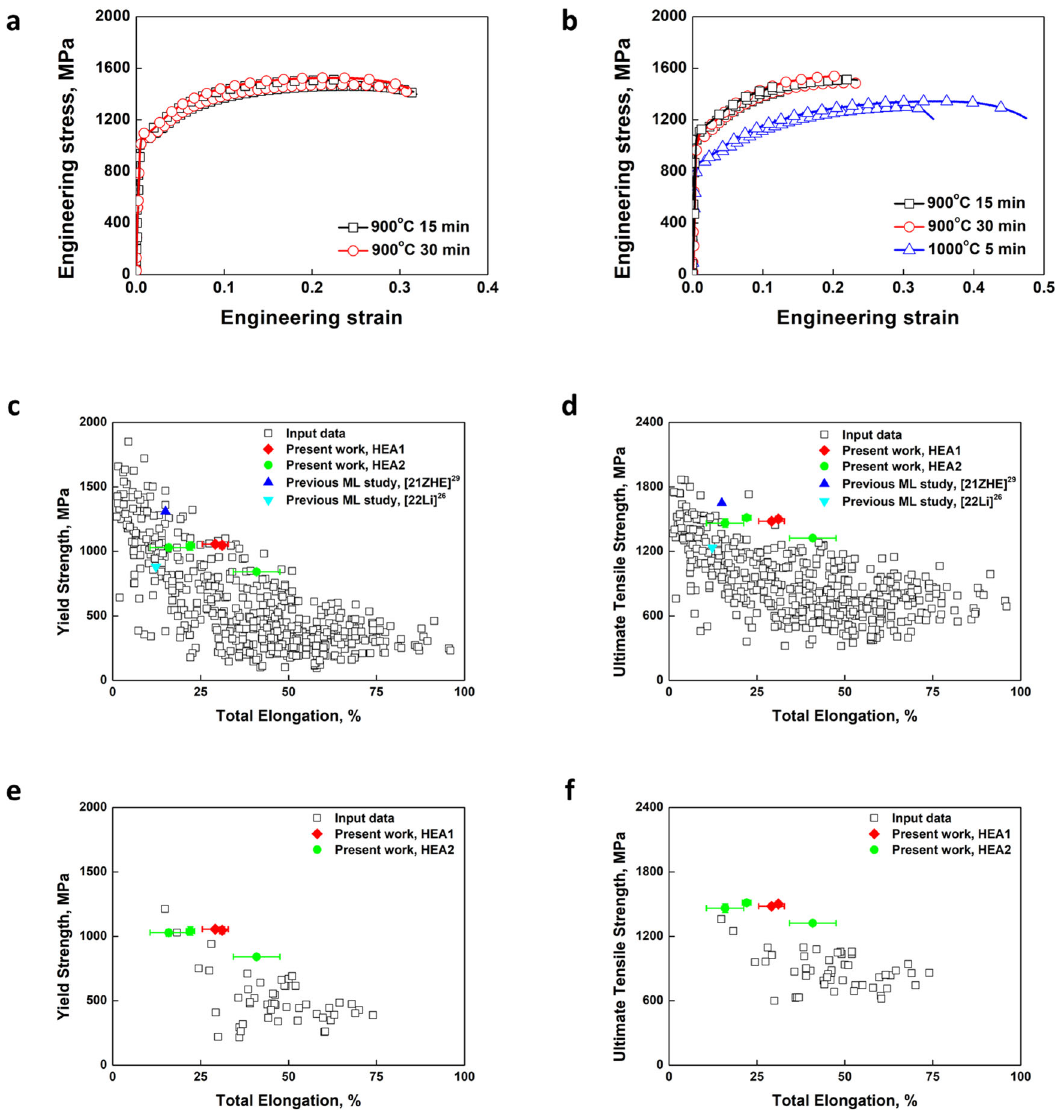
Fig. 3 Tensile properties. The engineering stress-strain curves of ( a ) HEA1 and ( b ) HEA2 measured in multiple tensile tests for each sample. Ashby plots of ( c ) YS vs T.EL. and ( d ) UTS vs T.EL., for the HEAs from previous machine learning studies 26,29 , HEA1, HEA2, and the input data. Ashby plots of ( e ) YS vs T.EL. and ( f ) UTS vs T.EL., for HEA1, HEA2, and the input data with similar process conditions to HEA1 and HEA2. The references of the input data are given in the supplementary